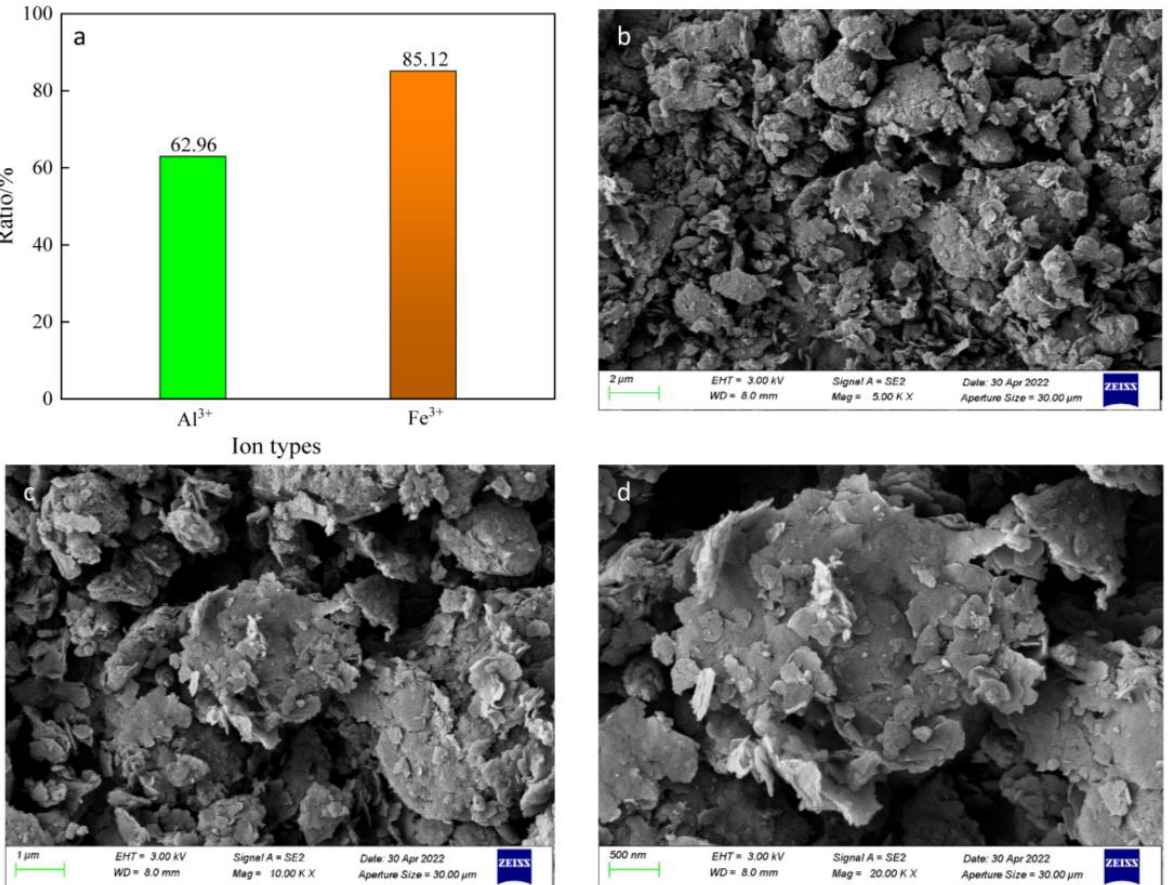
Figure 3. Leaching ratio and SEM image of direct acid leached residue. ( a ) is the leaching ratios of aluminum and iron ions, ( b ) is an SEM image of the acid leached residue, and ( c , d ) are enlarged images of the central part of Figure 2b.